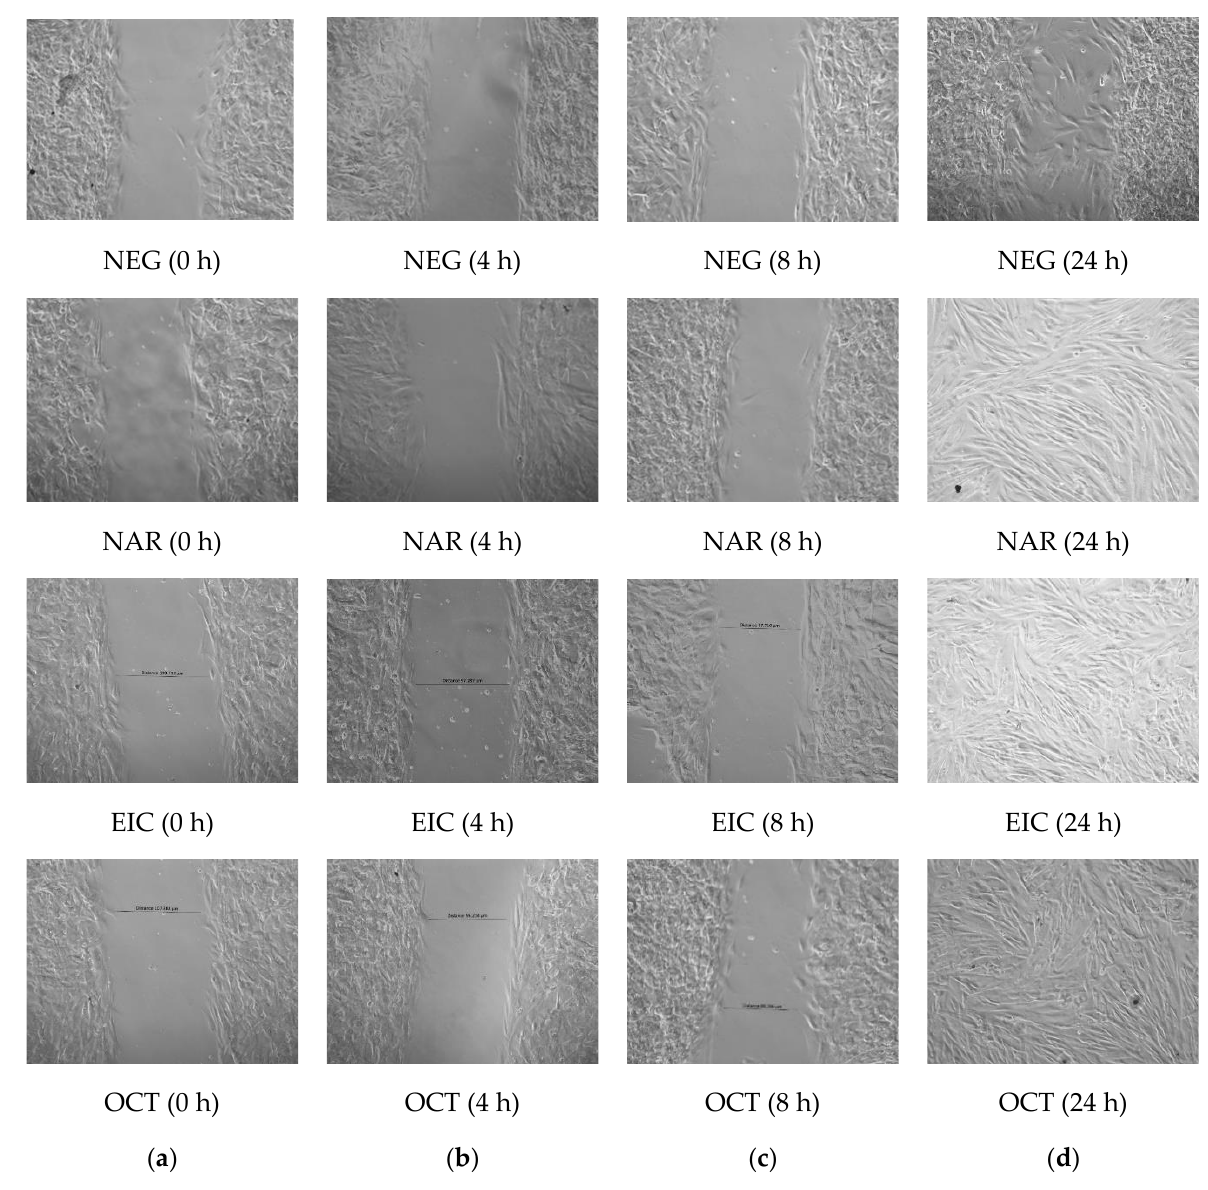
Figure 2. Fibroblast migration of untreated (NEG) vs. treated cells (POS, NAR, EIC and OCT) at ( a ) 0 h ( b ) after 4 h ( c ) after 8 h and ( d ) after 24 h.